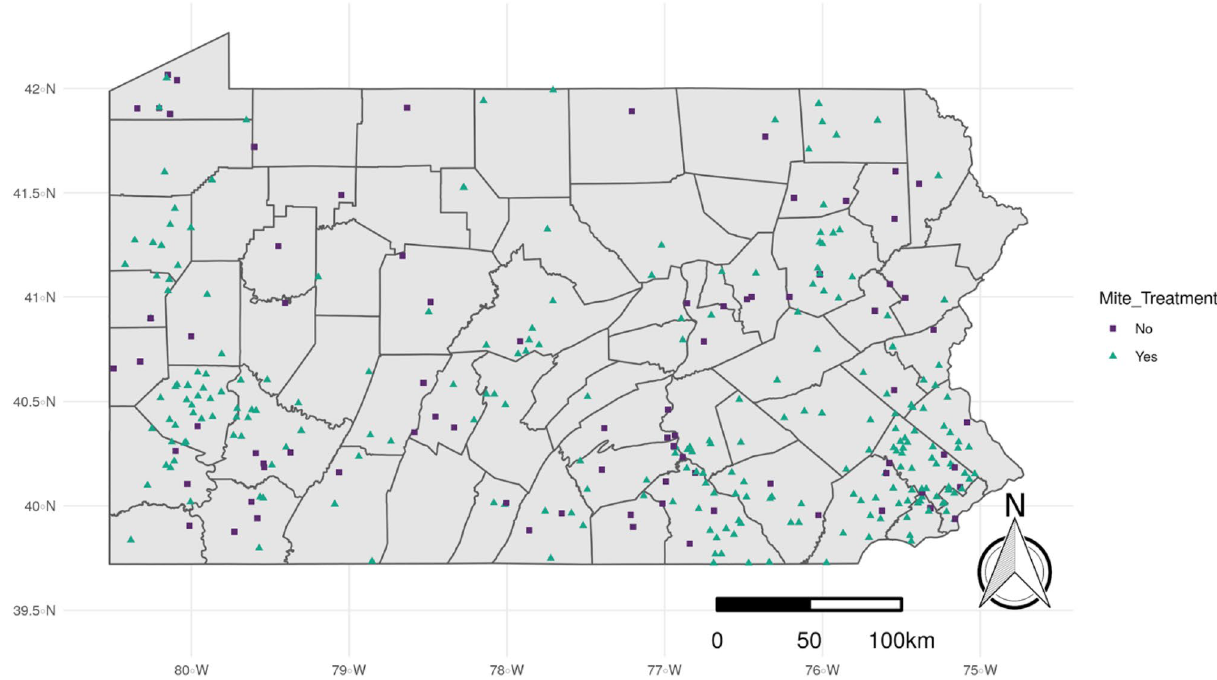
Figure 1. Locations of Pennsylvania beekeeper survey respondents from 2016 to 2019, stratified by use of treatment for Varroa mites (257 treated and 85 untreated apiaries). Only treated apiaries were modeled. The map has been generated by the authors in R 3.6.2 50 , using the sf 72 , the raster 56 , the ggplot2 73 and the cowplot 74